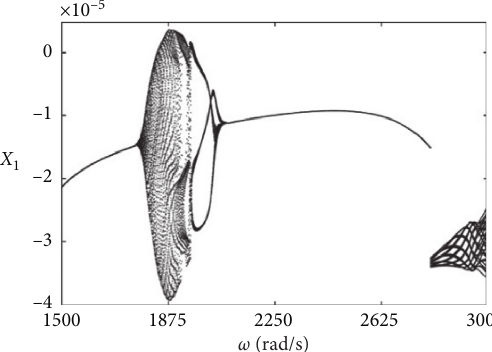
Figure 9: Bifurcation diagram of rotor with k